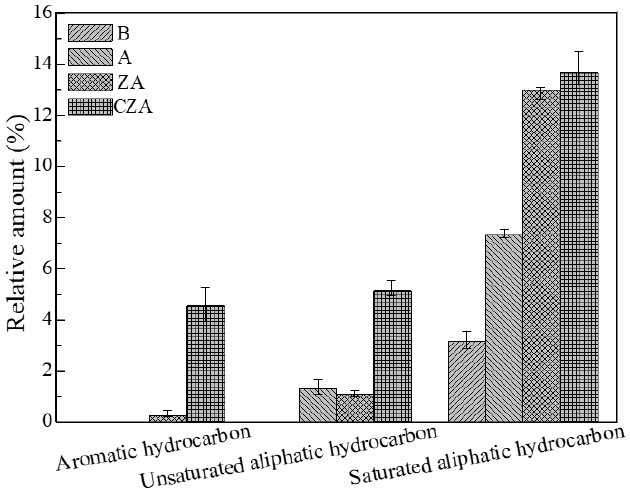
Figure 10. E ff ects of the catalysts on the hydrocarbon